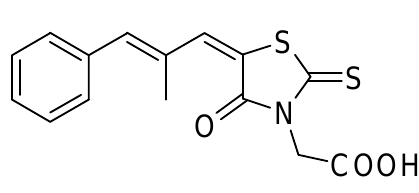
Figure 1. Structure of